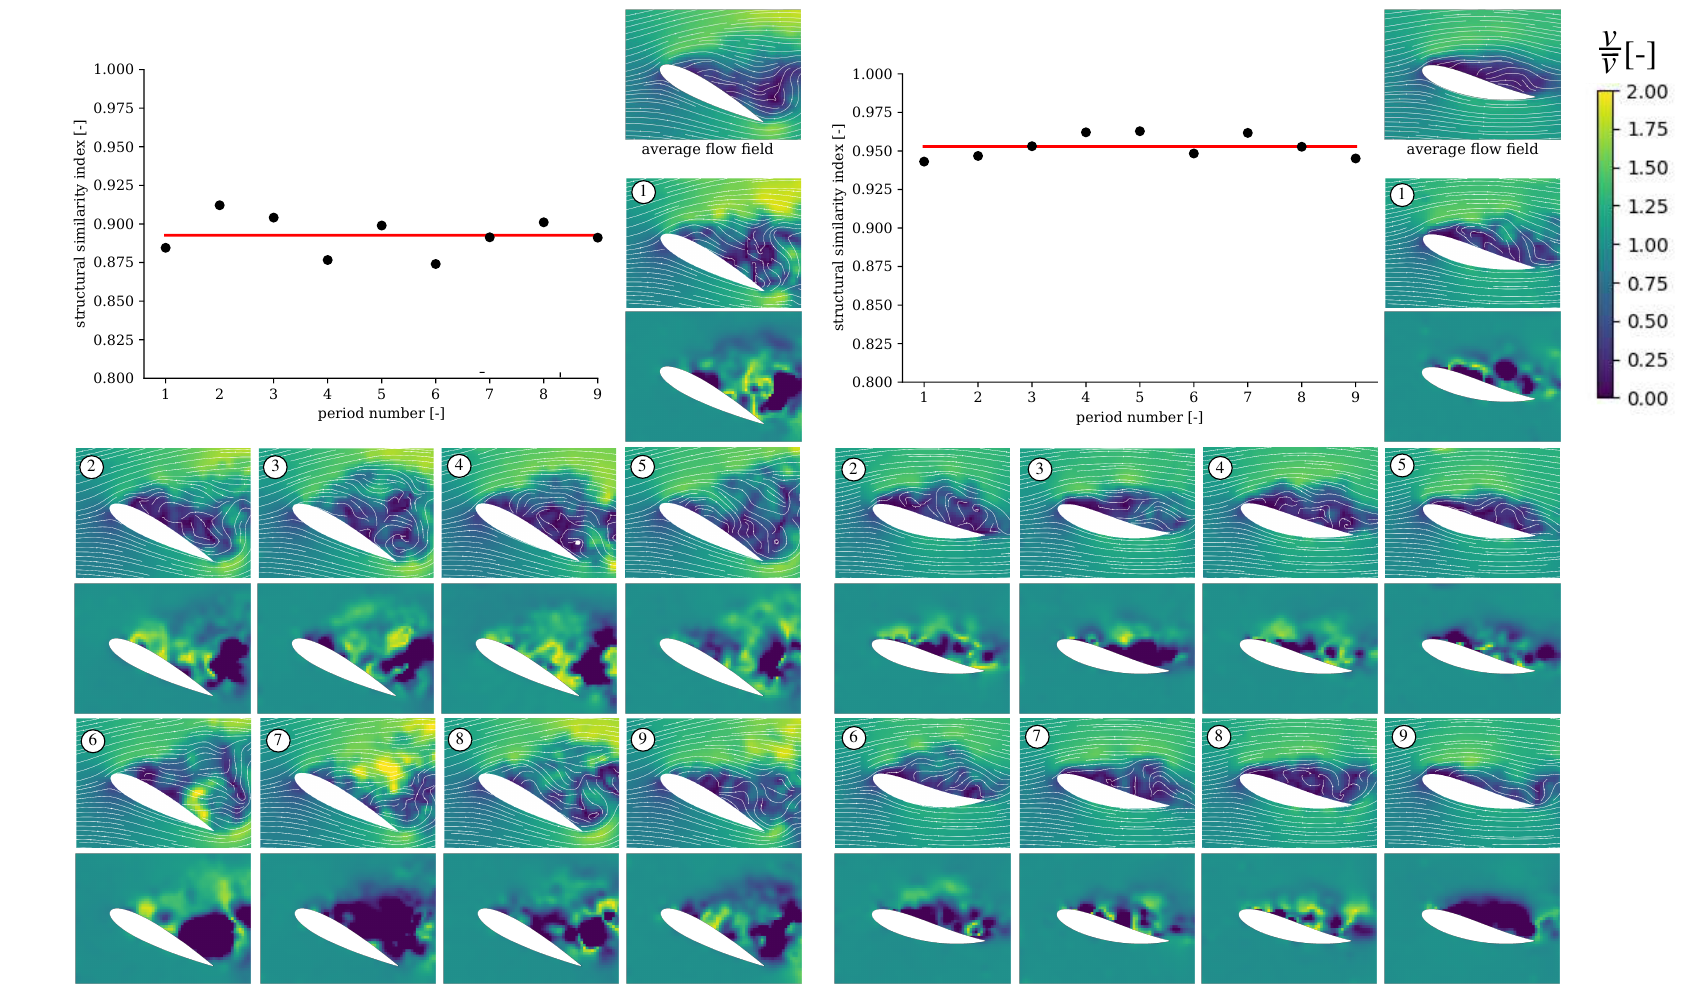
Figure 9. Averaged flow field (top plot), instantaneous flow fields (numbered 1–9) and relative velocity difference to the average (underneath) around the rigid ( left ) and the flexible ( right ) hydrofoil for an identical angle of incidence in multiple periods ( α = 28°, k = 0.24). The diagrams show the structural similarity of the flow fields for each